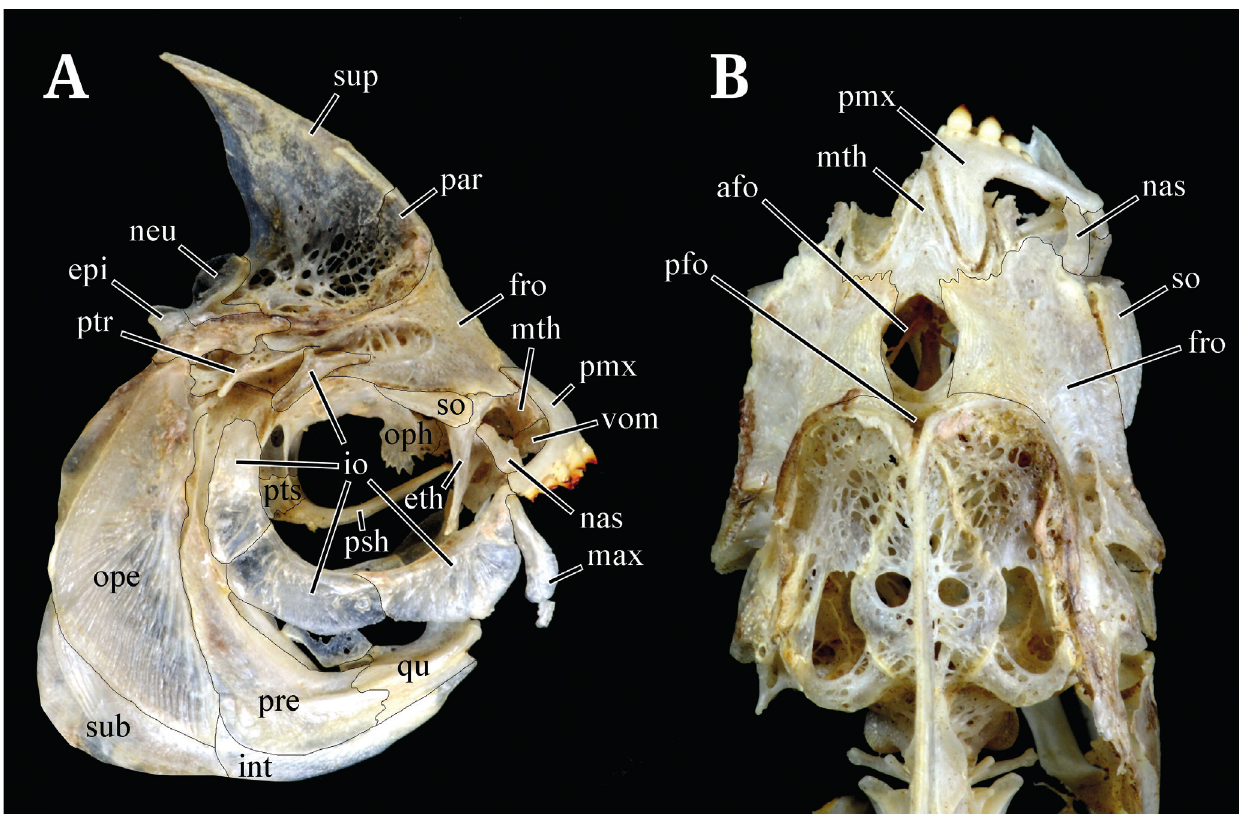
FIGURE 2 | Osteology of the head of Myloplus nigrolineatus , INPA 53281, 180.3 mm SL, Manaus, rio Negro nearby Manaus: A. lateral view; B. dorsal view. afo , anterior fontanel; epi , epiotic; eth , lateral ethmoid; fro , frontal; int , interopercle; io , infraorbitals; max , maxillary; mth , mesethmoid; nas , nasal; neu , neural; ope , opercle; oph , orbitosphenoid; par , parietal; pfo , posterior fontanel; pmx , premaxillary; pre , preopercle; psh , parasphenoid; ptr , pterotic; pts , pterosphenoid; qu , quadrate; so , supraorbital; sub , subopercle; sup , supraoccipital; vom ,